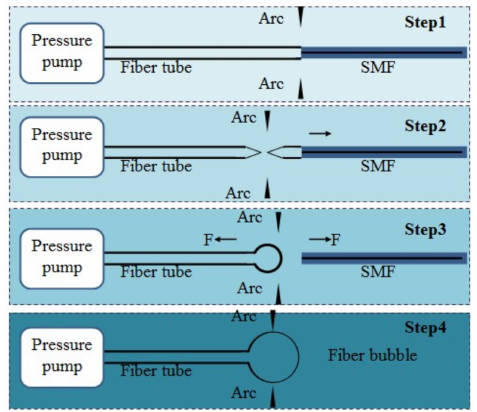
Figure 1. Fabrication processes of the proposed single-ended